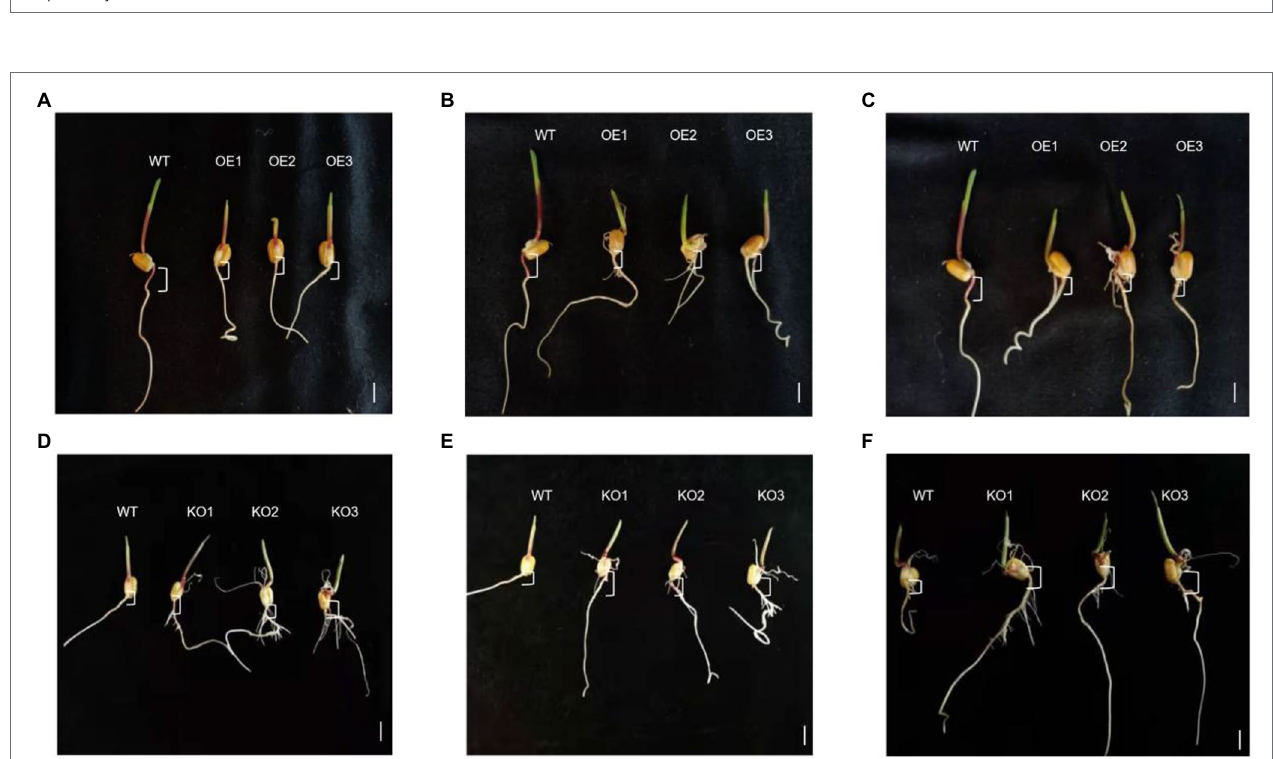
FIGURE 10 | Comparison of maize hypocotyl lengths of transgenic-positive plants. The asterisks (* or **) represent the significant differences at p < 0.05 or p < 0.01, respectively.